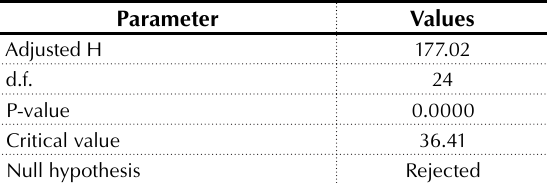
Table 4. Kruskal-Wallis test results